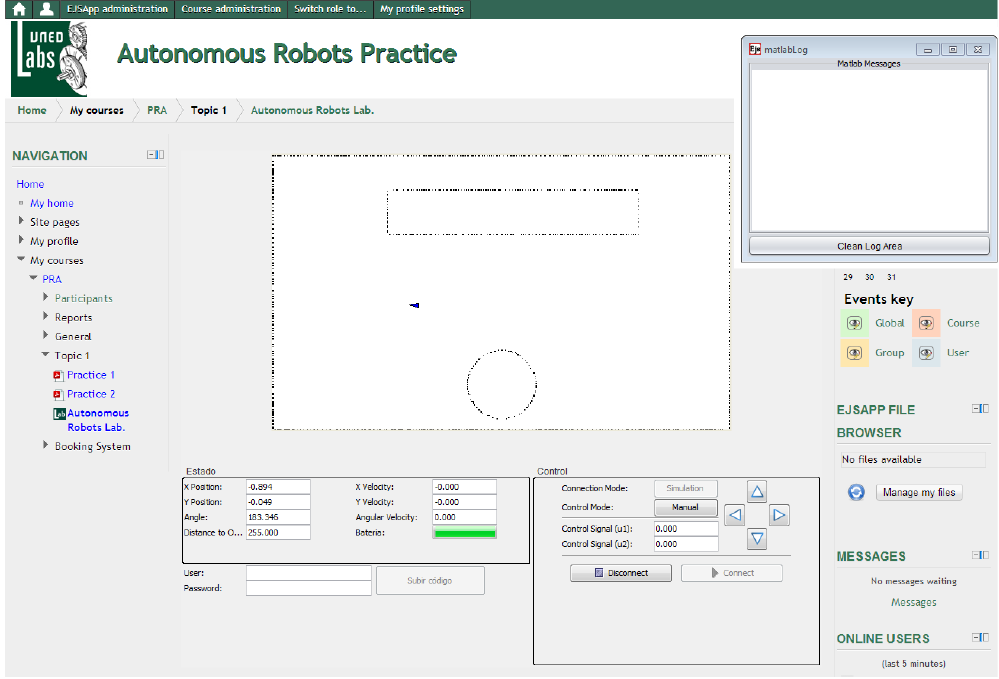
Figure 9. Example of a successful execution of a student